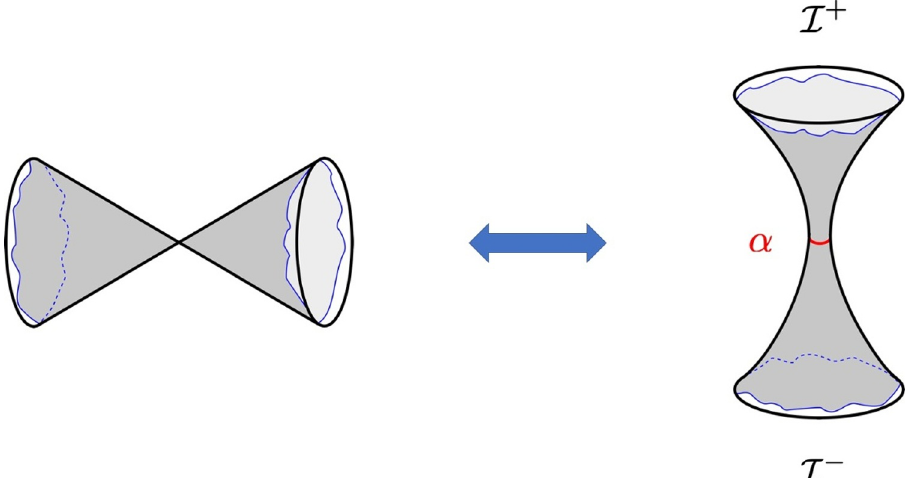
Figure 2 . Under the analytic continuation b ! i(cid:11) , J 0 of [21] is mapped to nearly global dS 2